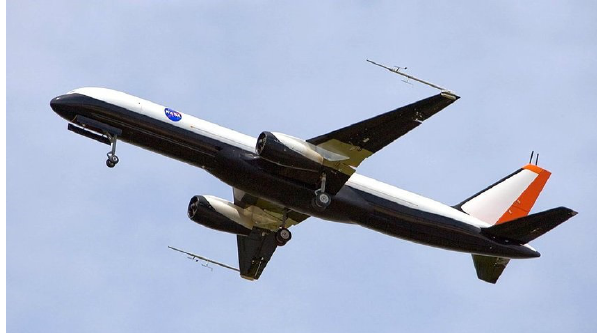
Figure 1. NASA GTM-T2